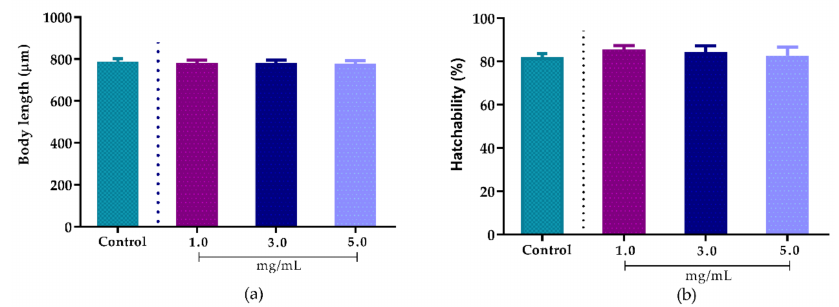
Figure 5. E ff ect of Agave sisalana agro-industrial residue extract on worm development. ( a ) Body length after treatments with 1.0, 3.0 and 5.0 mg / mL of extract; ( b ) Hatchability percentage after treatments with 1.0, 3.0 and 5.0 mg / mL of